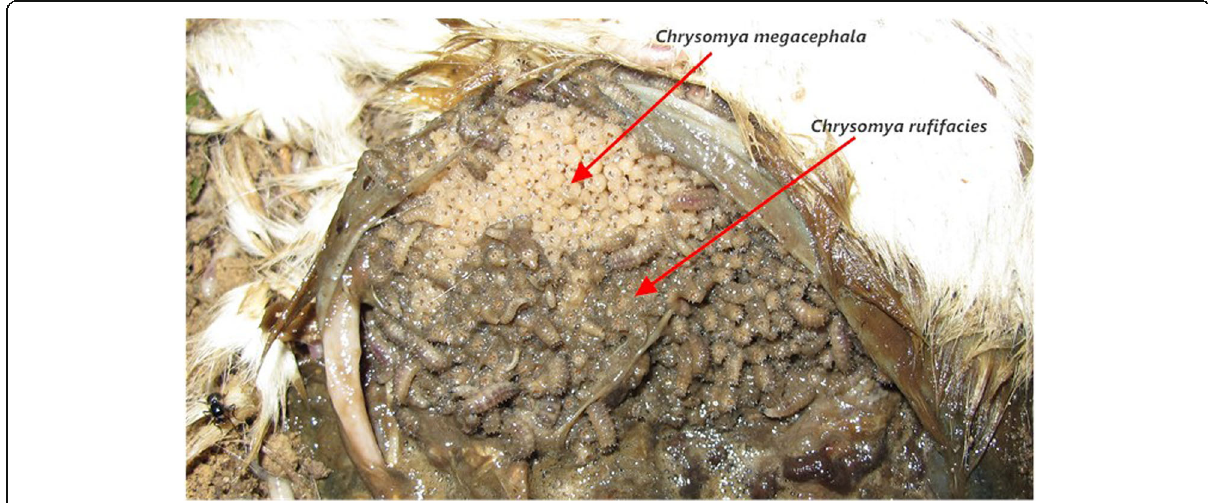
Fig. 2 Image showing species-specific aggregation of Ch. rufifacies and Ch. megacephala in rat